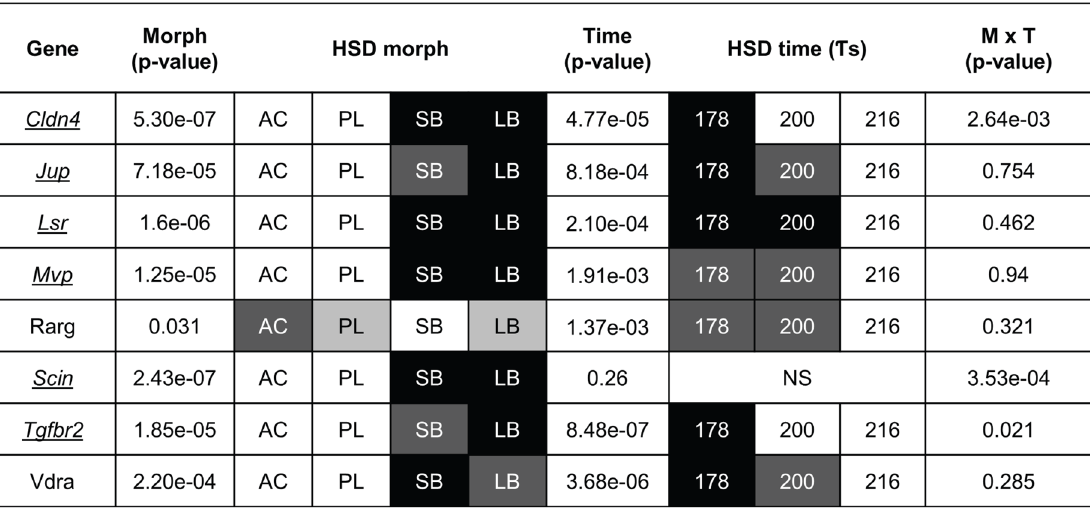
Figure 6. Expression differences of craniofacial candidate genes in developing head of Arctic charr morphs. Relative expression ratios, calculated from the qPCR data, were subjected to an ANOVA to test the expression differences amongst four charr groups and three time points ( τ s ). The underlined gene names reflect significant difference between SB and AC-charr. A post hoc Tukey’s test (HSD) was performed to determine the effects of morphs, time and morph by time interaction (M X T). White boxes represent low expression, while black boxes represent high expression. The shading represents significant different expression between the samples ( α = 0.05, NS = not significant). The genes studied were, Claudin 4 (Cldn4), adseverin (Scin), Junction plakoglobin (Jup), Lipolysis stimulated lipoprotein receptor (Lsr), Major vault protein (Mvp), Transforming growth factor beta receptor II (Tgfbr2) Vitamin D receptor a (Vdra) and Retinoic acid receptor gamma-A